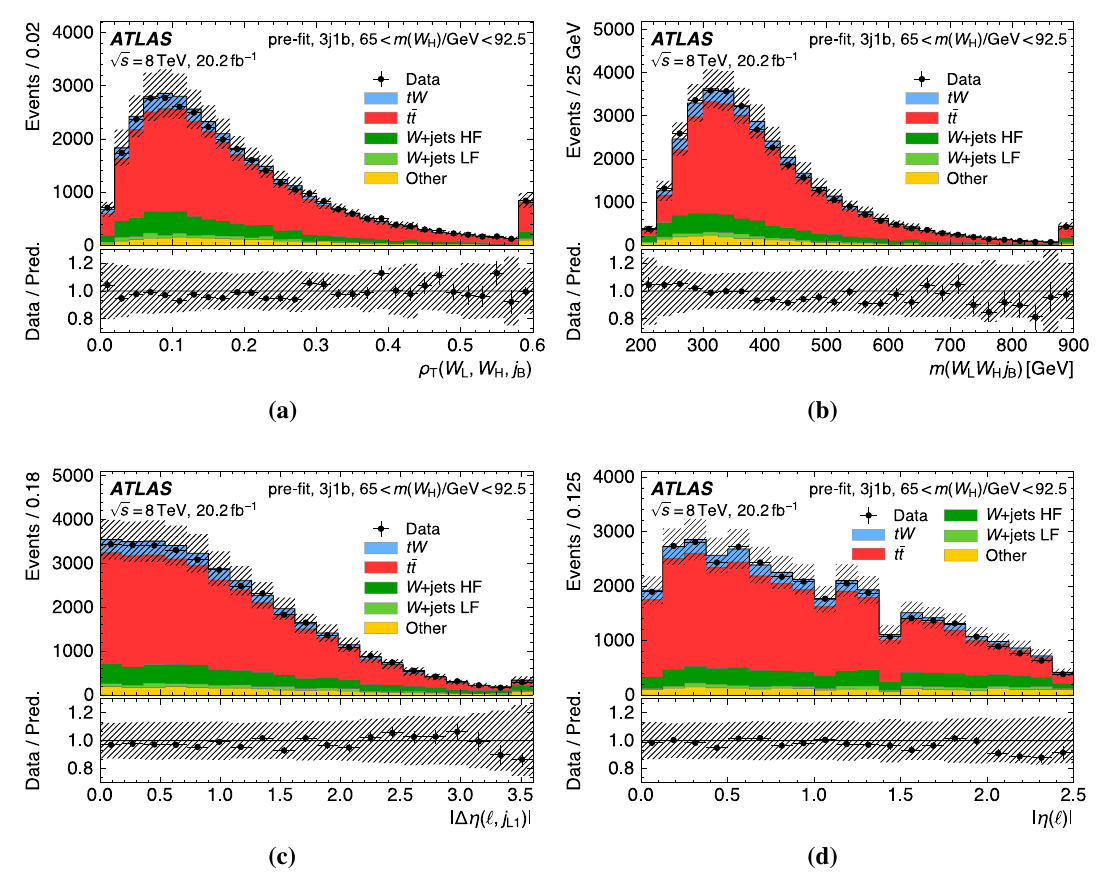
Fig. 3 Pre-fit distributions of the NN input variables in the tW signal (3j1b) region with 65GeV ≤ m ( W H ) ≤ 92 . 5GeV. Small backgrounds aresubsumedunder‘Other’.Thesimulateddistributionsarenormalised totheirtheoreticalcross-sections.Thedasheduncertaintybandincludes